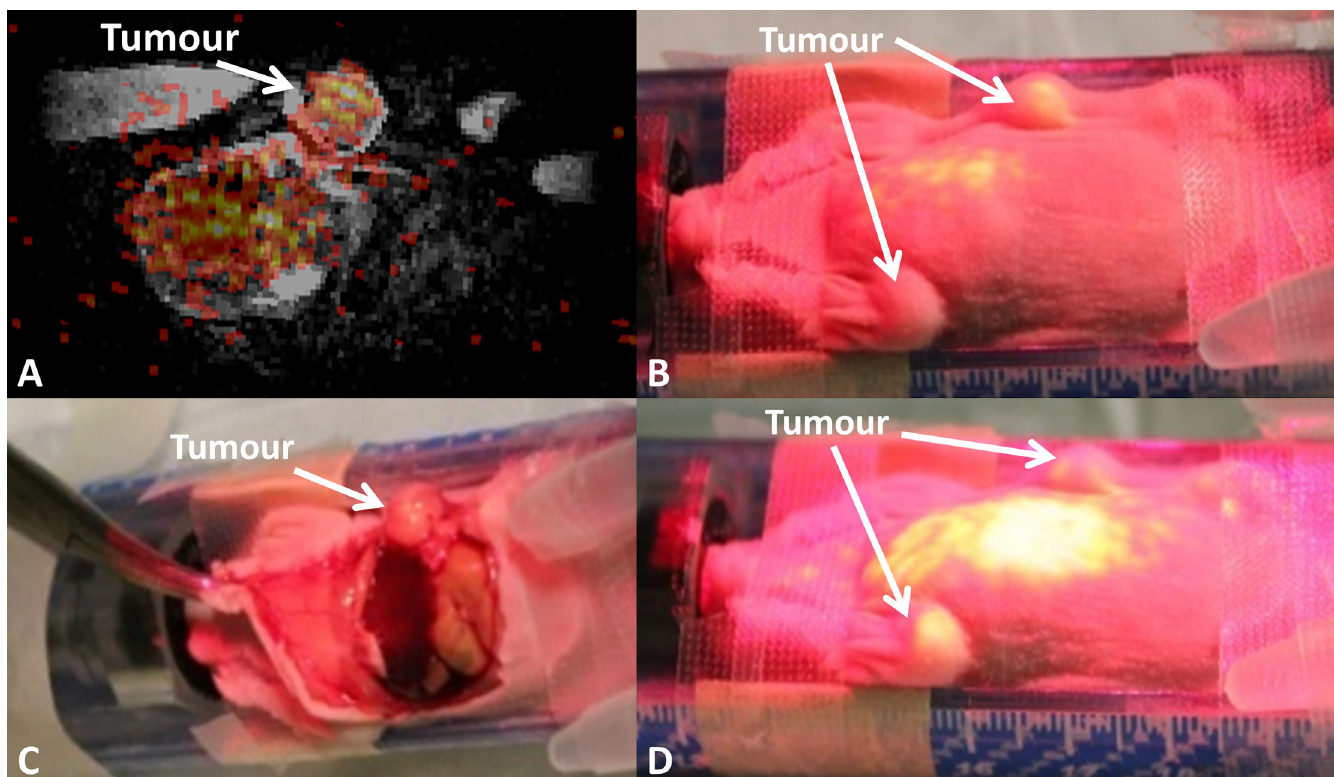
Fig 4. Augmented reality guided procedure with the breast carcinoma xenograft model demonstrating breast tumors in the left and right mammary fat pads. (A) A registered PET/MRI image coronal slice for AR guide procedure. (B) The AR PET image projected on the mouse’s body surface highlights the tumor location. (C) The dissected mouse reveals the tumor location on the right in the same location. (D) AR projection on the mouse demonstrates the tumor location on the left side and the 64Cu isotope uptake in the lungs and liver.